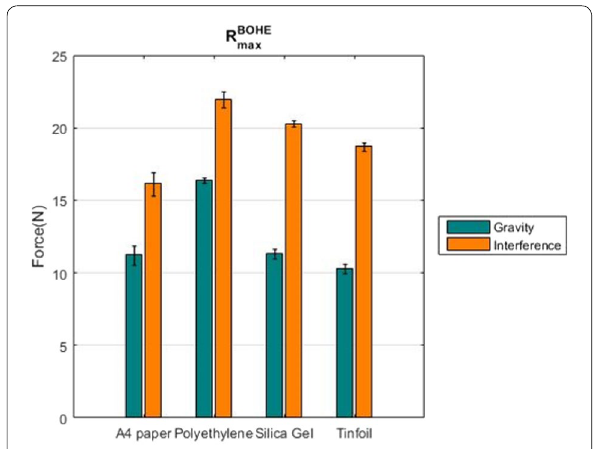
Figure 8 Grasping ability of BOHE grasping mode with the maximal object